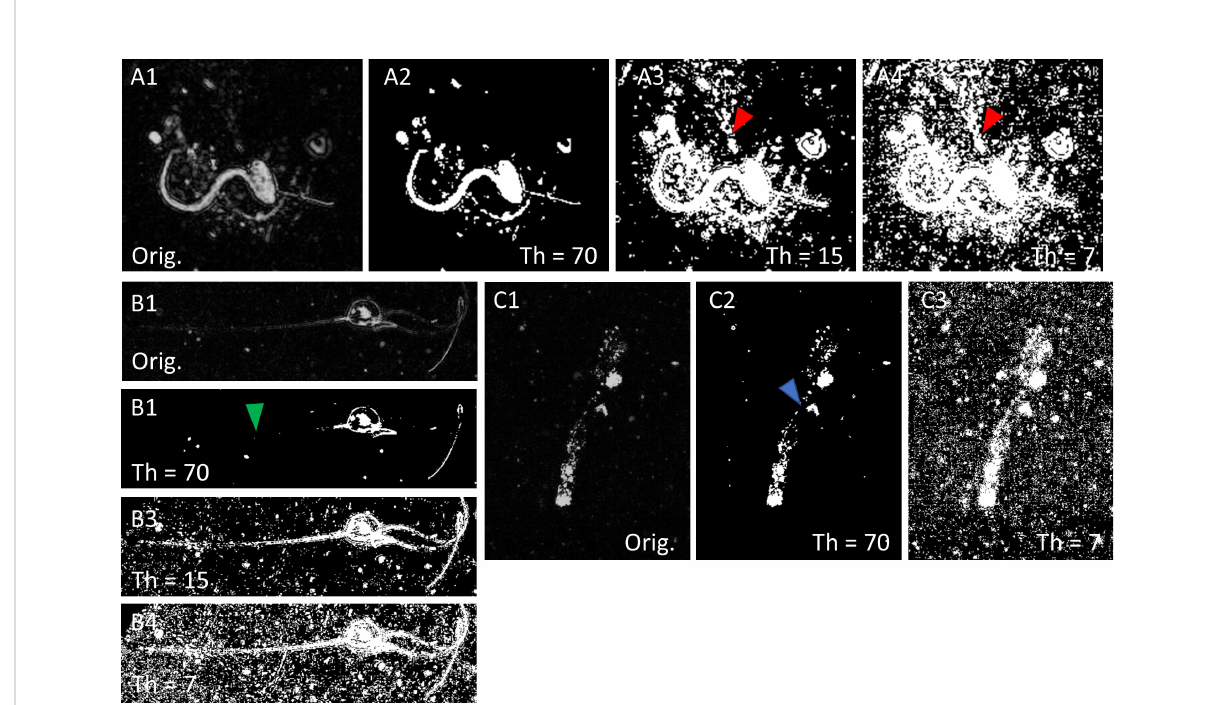
FIGURE 3 Images of plankton and particles in the Gulf of Trieste using shadowgraphy (note that images are inverted for better contrast of smaller objects). (A) Appendicularian ( Oikopleura sp.) actively fi ltering in its house, (B) a hydromedusa, (C) a marine snow particle. The original gray scale images (A1, B1, C1) were binarized at various threshold levels (Th) (A2, 3, 4, B2, 3, 4, C2, 3) . A high threshold level (Th = 70) isolates plankton and denser particles from the background while a low threshold makes faint particles and gel structures appear. Even at the lowest practical threshold level shown here (A4, B4, C3) , particles are not exhaustively detected. Red arrows: food tube of the appendicularian house. Green arrow: missing tentacle in the binarization. Blue arrow: mucus strands connect lower and upper portions of the marine snow particle. By optimizing image algorithms to perfectly render the shapes of zooplankton for taxonomic identi fi cation, the vast abundance of faint particles (A4, B4, C3) remains